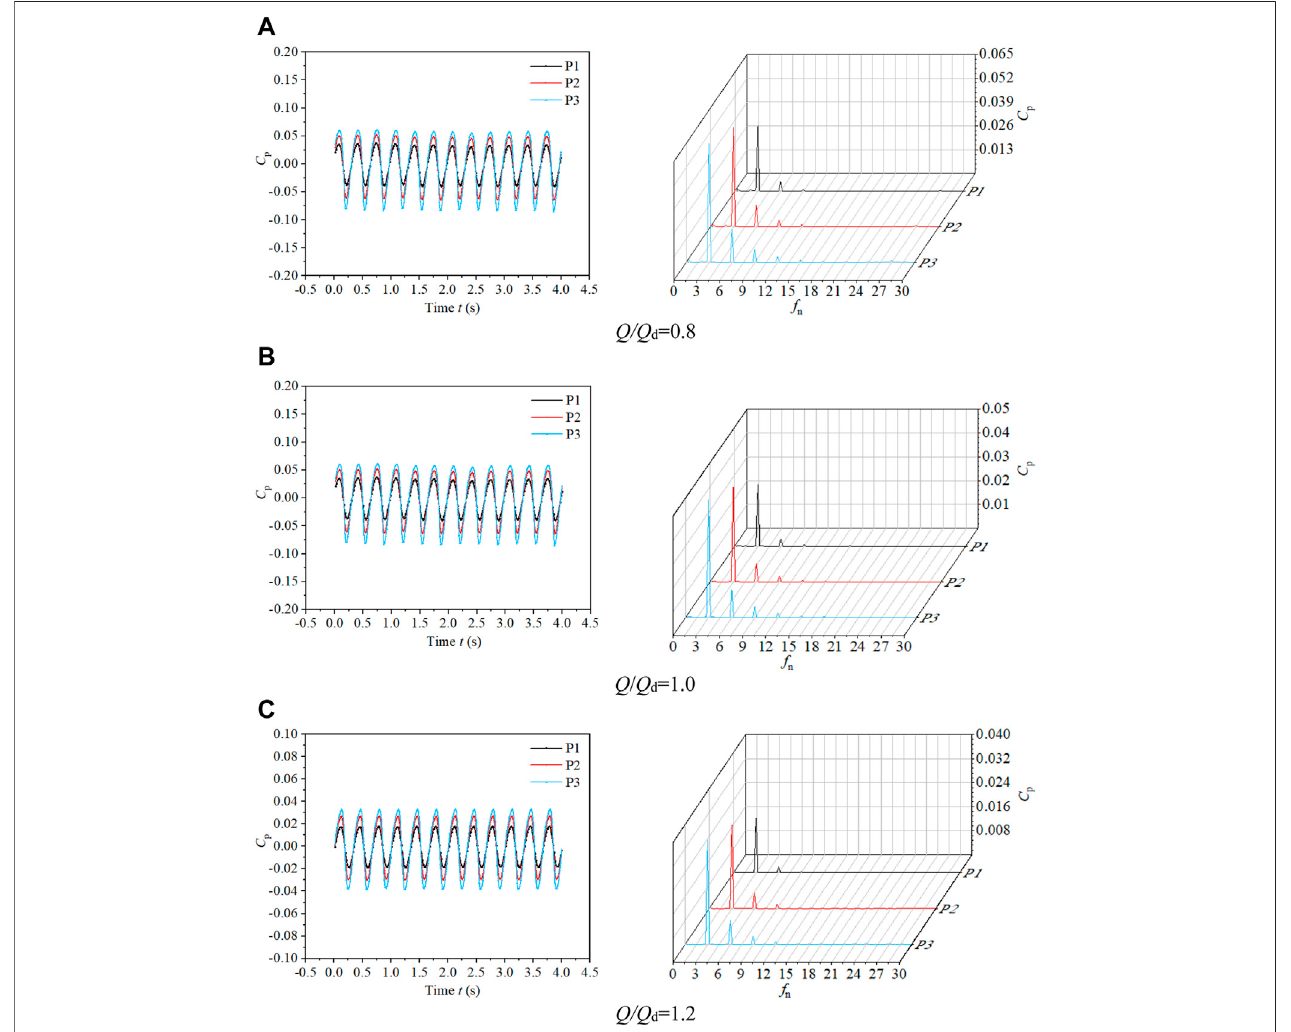
FIGURE 12 | Time domain chart and frequency domain chart of pressure pulsation on the impeller inlet at monitoring points P1-P3 under different conditions. (A)